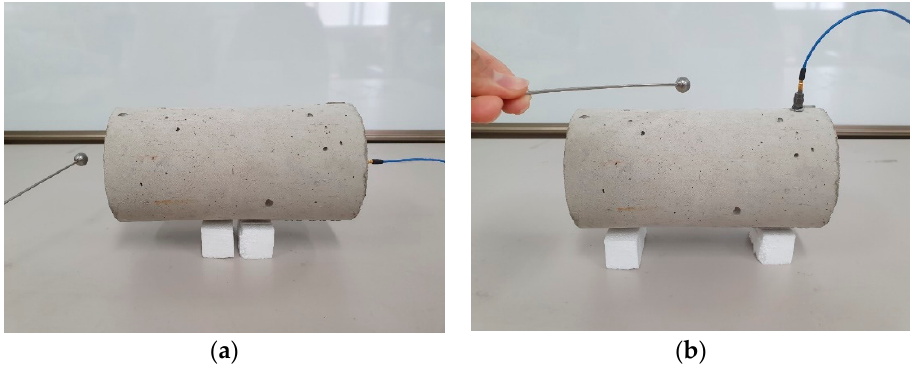
Figure 2. Resonance frequency test setup. ( a ) longitudinal mode and ( b ) transverse mode.